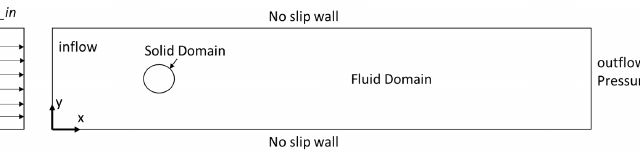
Figure 3. Domain and boundary conditions for vortex analysis.